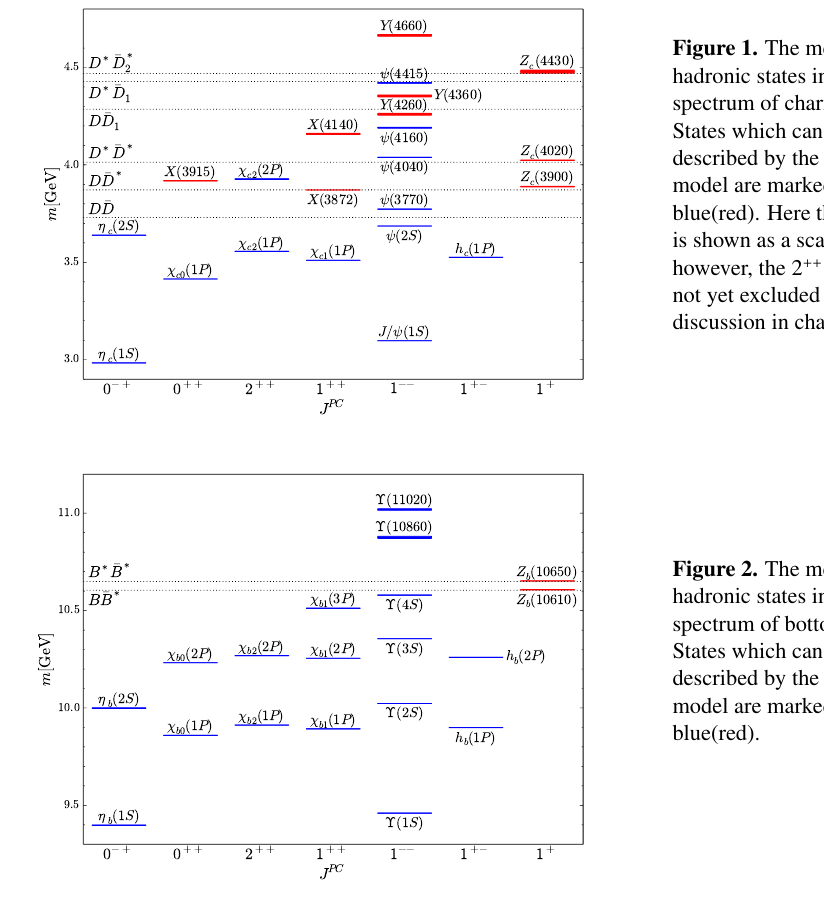
Figure 1. The measured hadronic states in the spectrum of charmonium. States which can(not) be described by the quark model are marked with blue(red). Here the X (3915) is shown as a scalar state, however, the 2 ++ option is not yet excluded — see the discussion in chapter 4.2.